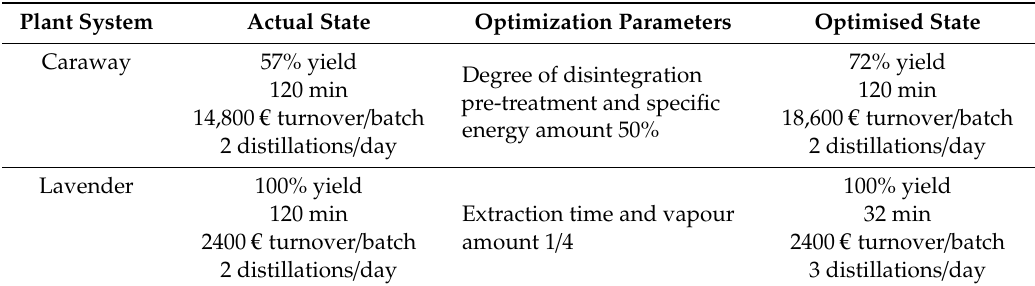
Table 7. Summary of model-based optimizations for steam